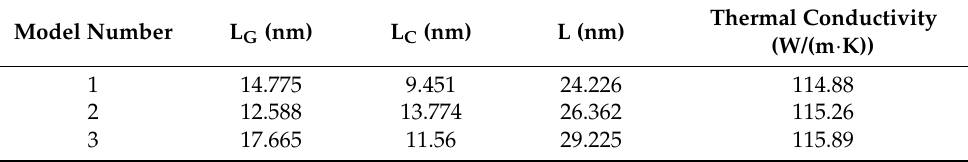
Table 4. The composition of the test samples.